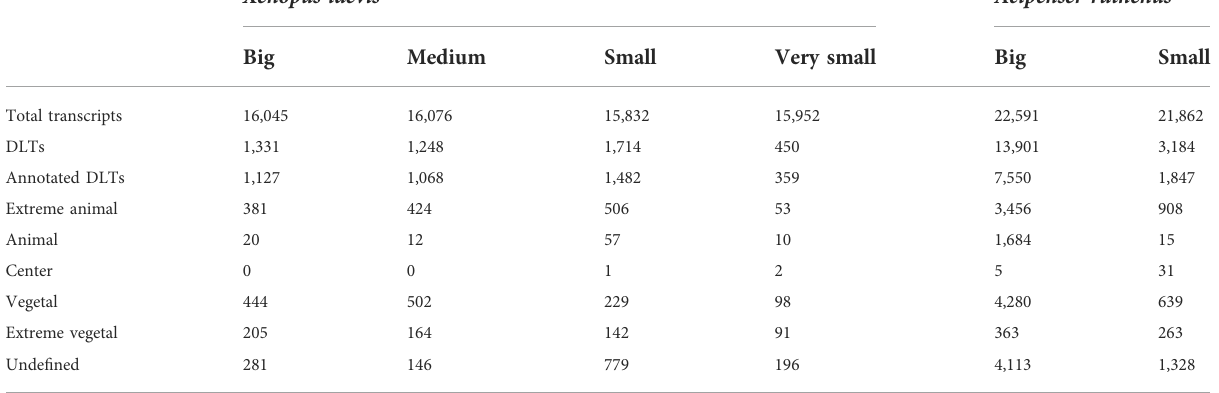
TABLE 2 Number of differentially localized transcripts that are overabundant in the fi ve de fi ned localized pro fi les. Xenopus laevis Big Medium Small Very small Big